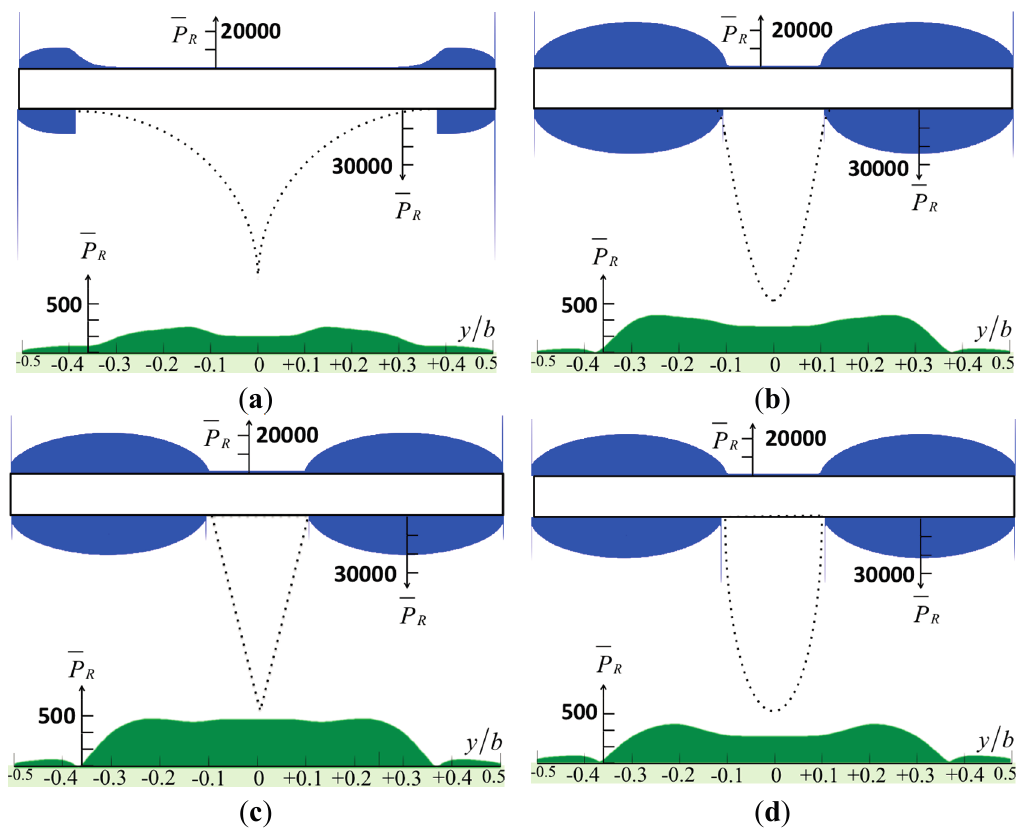
Figure 4. The normalized pressure in real part over the surfaces of the cantilever caused by various tip shapes: ( a ) the sharp model; ( b ) the sine-shaped model; ( c ) the cone-shaped model; and ( d ) the bell-shaped